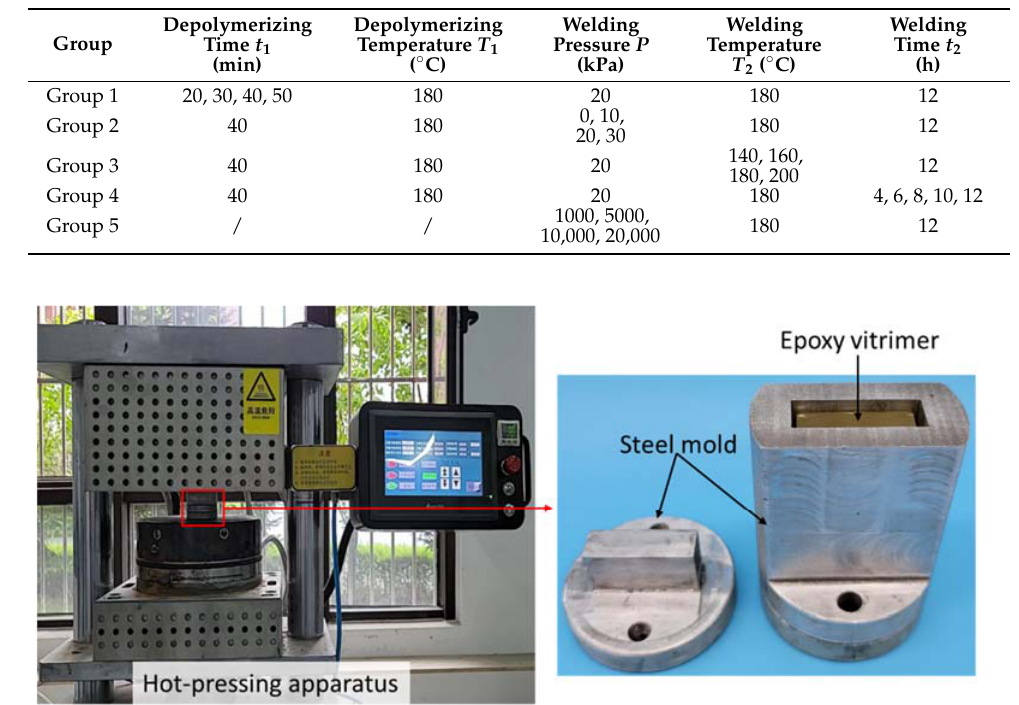
Figure 3. Experimental setup for welding.